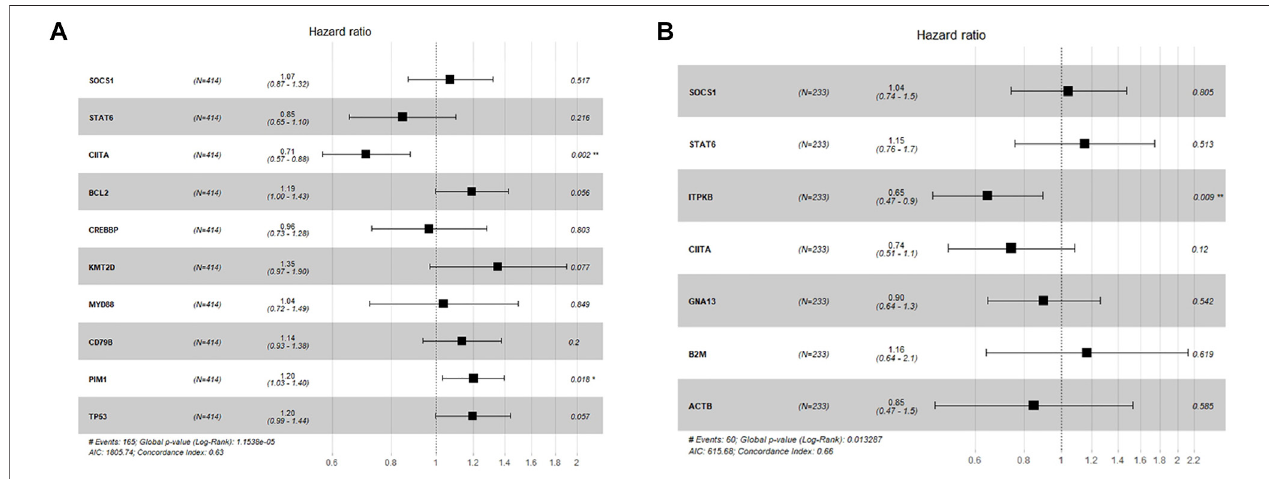
FIGURE6| ForestplotforCOXregressionanalysis. (A) MultivariatesurvivalanalysiswithSOCS1,STAT6,CIITA,BCL2,KMT2D,CREBBP, PIM1,MYD88,CD79B and TP53 in the GSE10846 whole cohort. (B) Multivariate survival analysis with SOCS1, STAT6, CIITA, GNA13, ITPKB, B2M and ACTB in the GSE10846 R-CHOP